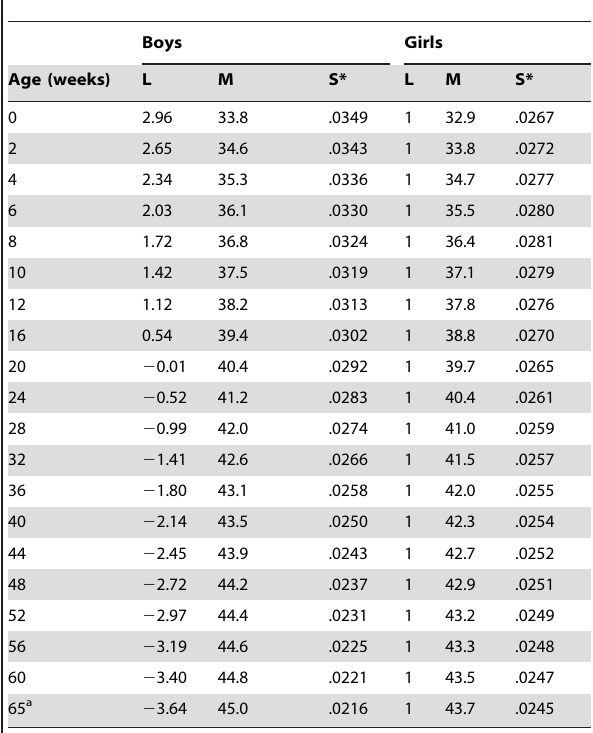
Table 5. New head circumference (cm) references for 0–15 months in Dutch children with Down syndrome: values of L (skewness), M (median), and S (coefficient of variation)*, categorized by age and sex.